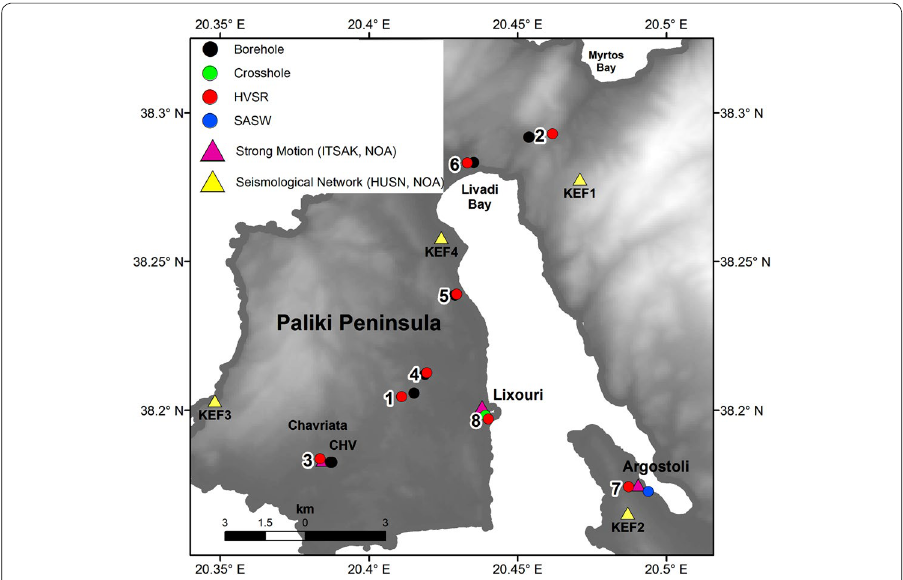
Fig. 7 Map showing the location of observation points regarding HVSR measurements, geotechnical data and earthquake recording stations. Numbers indicate the code of the observation points listed in Table